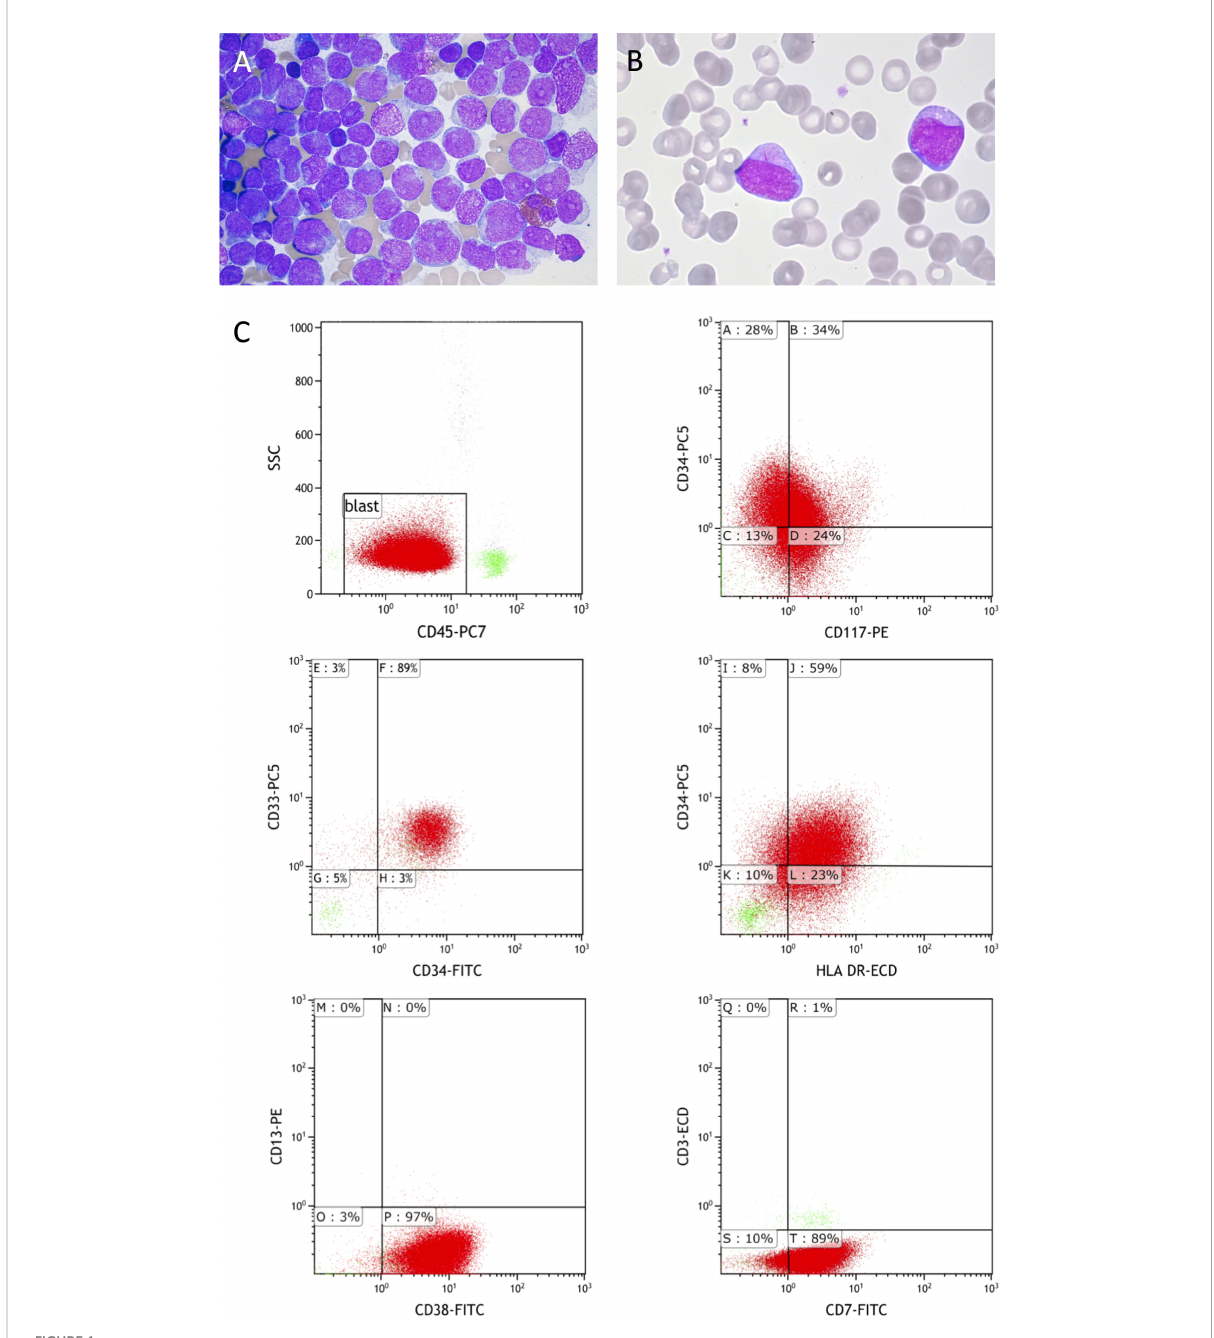
FIGURE 1 Cytology and immunophenotyping at initial diagnosis. Cytology of bone marrow (A) and peripheral blood (B) at initial diagnosis showing a subtotal in fi ltration of myelomonocytic blasts (A) and a blast with an Auer rod (B) . Immunophenotyping of bone marrow aspirate by fl ow cytometry (C) showing the gating strategy and relevant markers leading to the diagnosis of AML. ECD, extracellular domaine; SSC, Side scatter; PE, Phycoerythrine; FITC,